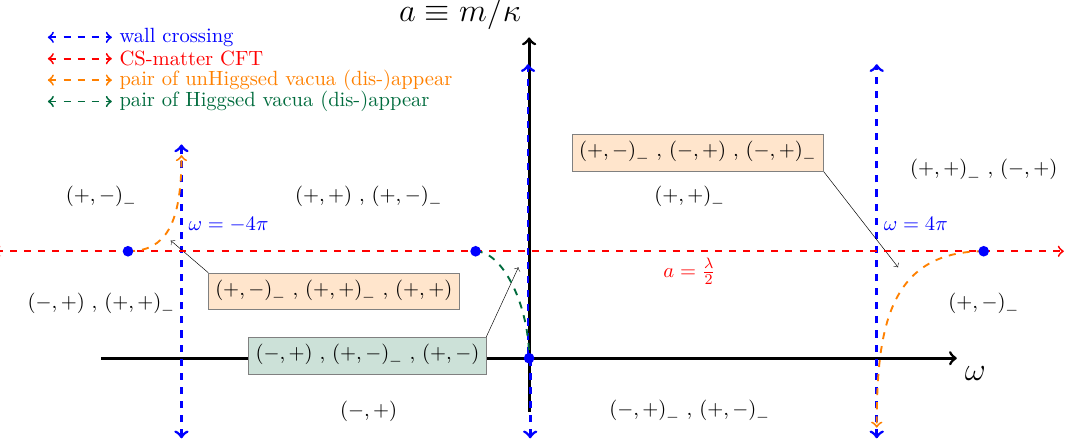
Figure 5. Complete phase diagram of the theory (2.3) at infinite N , small λ and λ 3 = 0